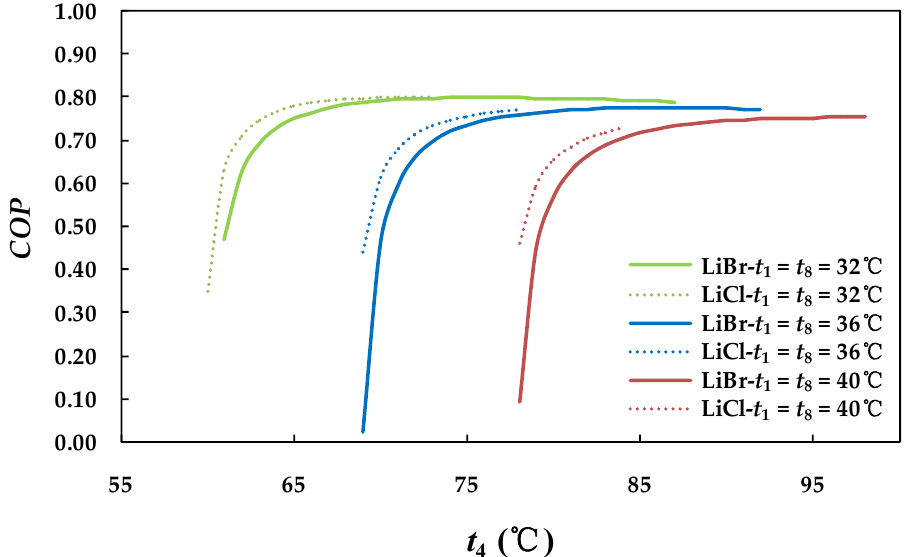
Figure 3. Generator temperature impact on the COP of the absorption system under various condenser and absorber temperature levels (32 °C, 36 °C, and 40 °C) for the two working pairs ( t 10 = 7 °C, ε = 0.7).